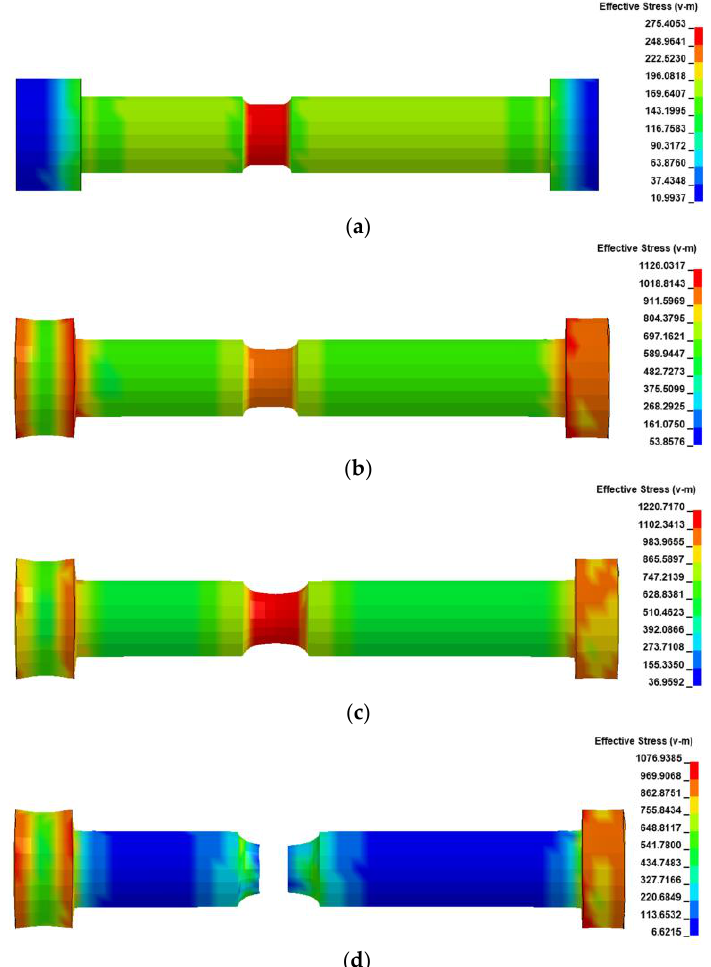
Figure 22. Effective stress contour plots of VCSB in the FEM-0: ( a ) A 1′ , ( b ) B 1′ , ( c ) C 1′ , ( d ) bolt frac- ture.